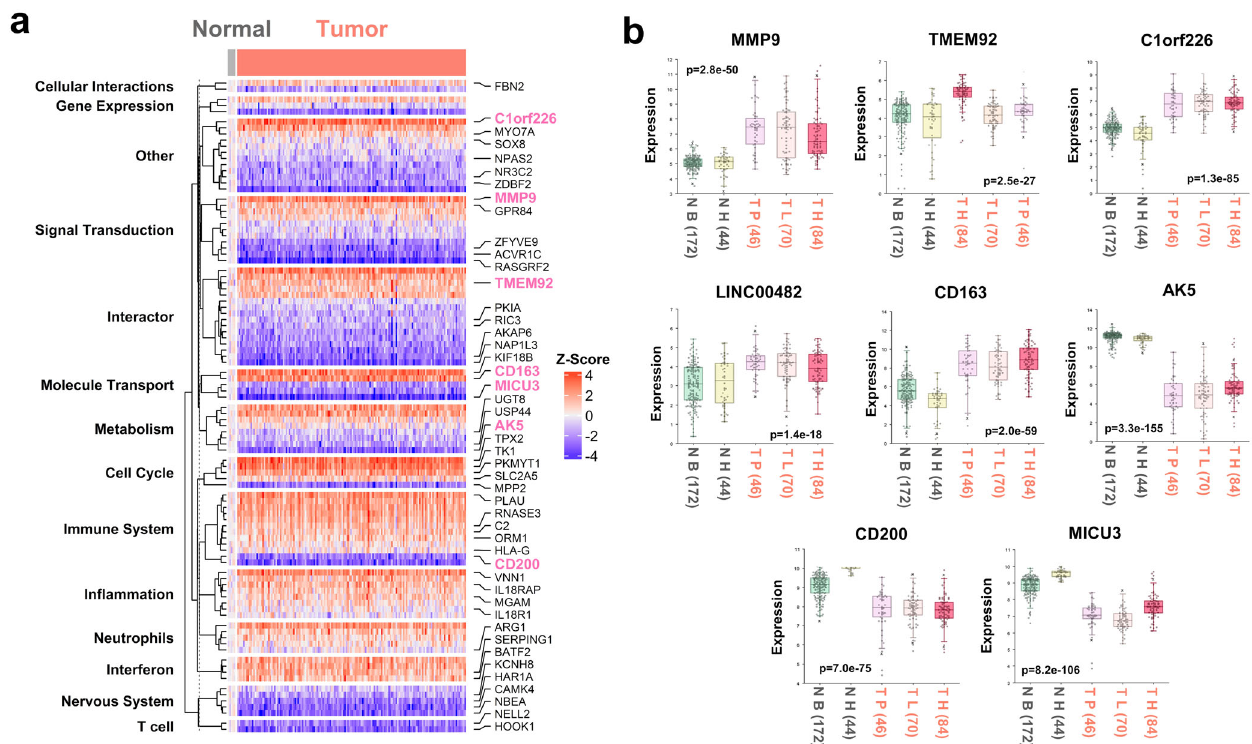
Fig. 6 Expression comparison of selected genes using TCGA-GBM transcriptome pro fi ling data and R2 genomics RNA pro fi ling data. a Expression of 98 genes from the 105 DEGs shown in main Fig. 4 in TCGA-GBM tissue data (22 genes are not available in TCGA). Potential function or pathway annotations are labeled on the left side of the heatmap. Genes in the GBM-Dx panel are labeled in hot pink. b The R2 genomics database was queried for eight genes (in the GBM-Dx panel) comparing normal brain data and GBM tissue data. The GBM patient cohorts used are “ N B (172) ” , representing the N Brain 172 (Berchtold) dataset, “ N H (44) ” , representing the N Brain 44 (Harris) dataset as the normal control group, “ T P (46) ” , representing the T Glioblastoma 46 (P fi ster) dataset, “ T L (70) ” , representing the T Glioblastoma 70 (Loef fl er) dataset, and “ T H (84) ” , representing the T Glioblastoma 84 (Hegi) dataset as the GBM tumor group. Boxplots were generated via R2: MegaSampler. Box limits indicate the range of the central 50% of the data (from 75th to 25th quantiles) with the central line marking the median value. The upper and lower whiskers are the maximum and minimum values of the data that are within 1.5 times the interquartile range over the 75th and 25th percentiles. P -values were computed via one way analysis of variance (ANOVA). Datasets of normal (N) samples are labeled in gray, and datasets of glioblastoma tumor (T) samples are labeled in salmon under the x -axis. The numbers in brackets represent the sample sizes in the